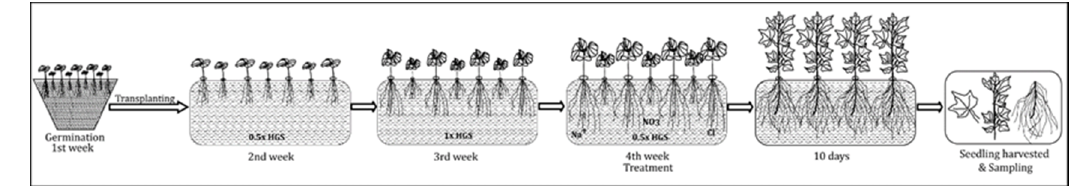
Figure 11. Schematic presentation of the experimental method.